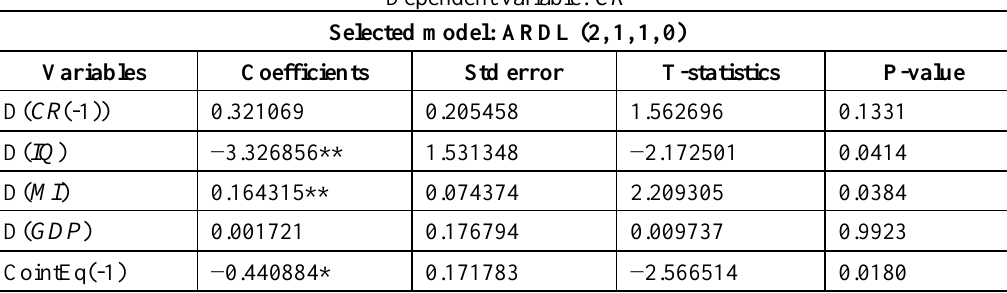
Table 3. Estimation Method: Short-Run Coefficients of ARDL Dependent variable: